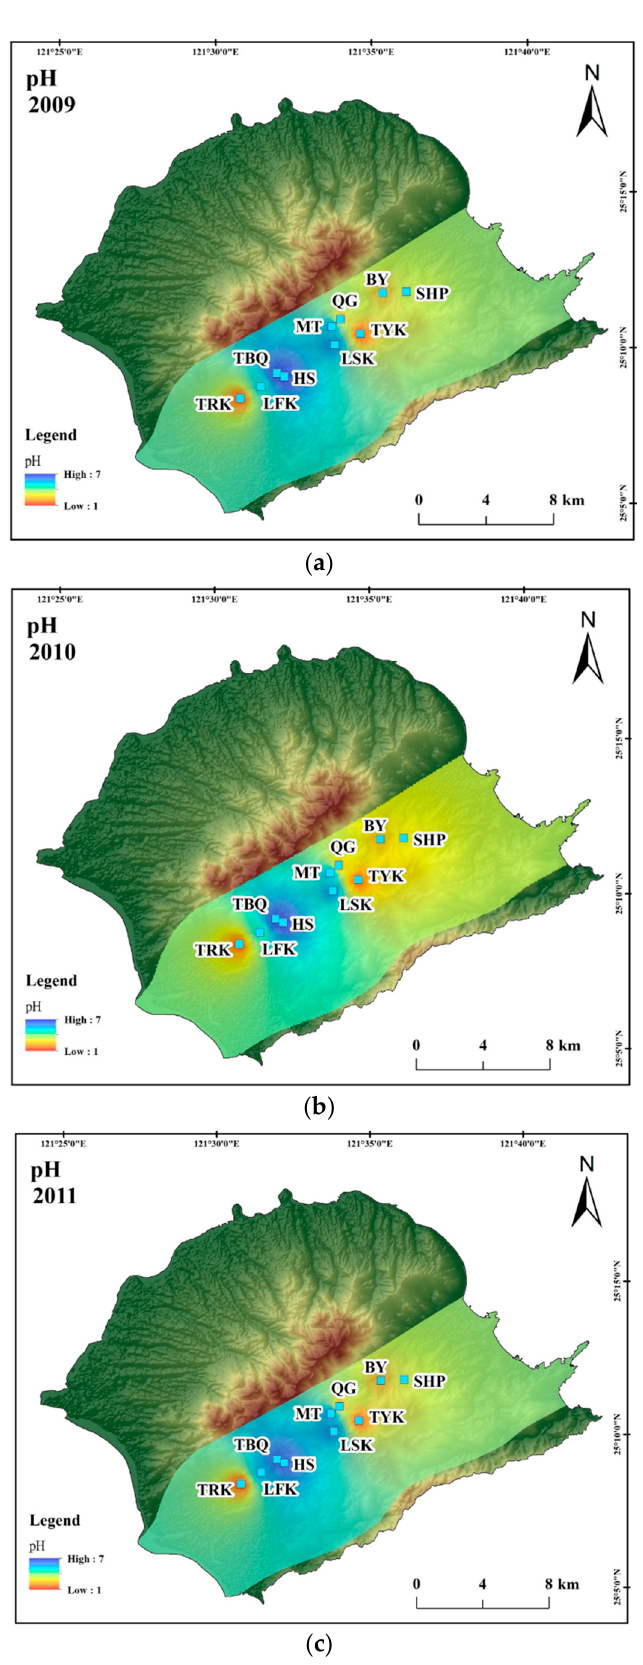
Figure 4. pH contour plots of the Tatun geothermal field hot spring for the three time periods ( a ) 2009; ( b ) 2010; ( c ) 2011.